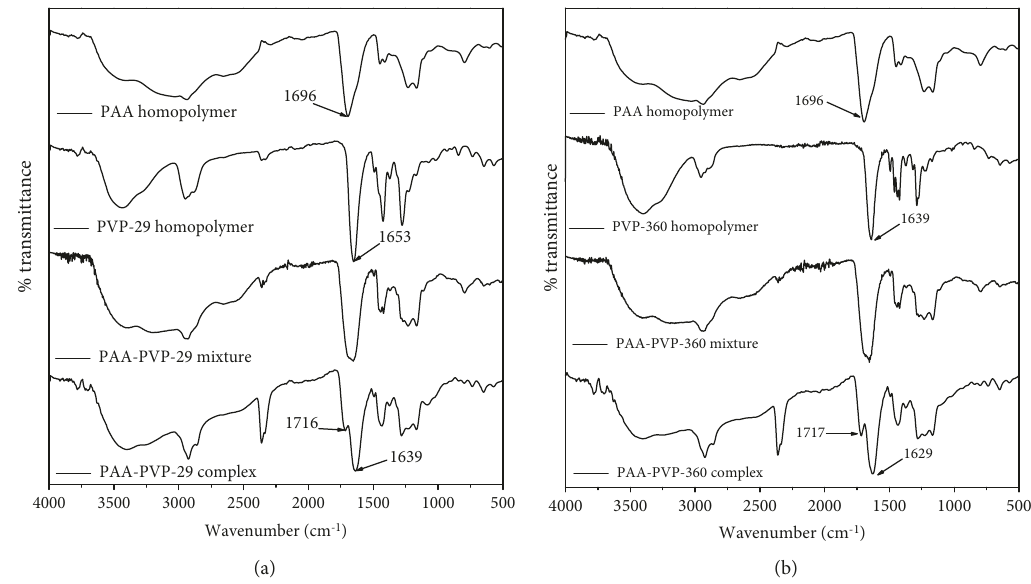
Figure 3: FTIR spectra of PAA, PVP, the physical mixture of PAA and PVP, and the PAA-PVP complexes: (a) PVP-29 and (b) PVP-360.